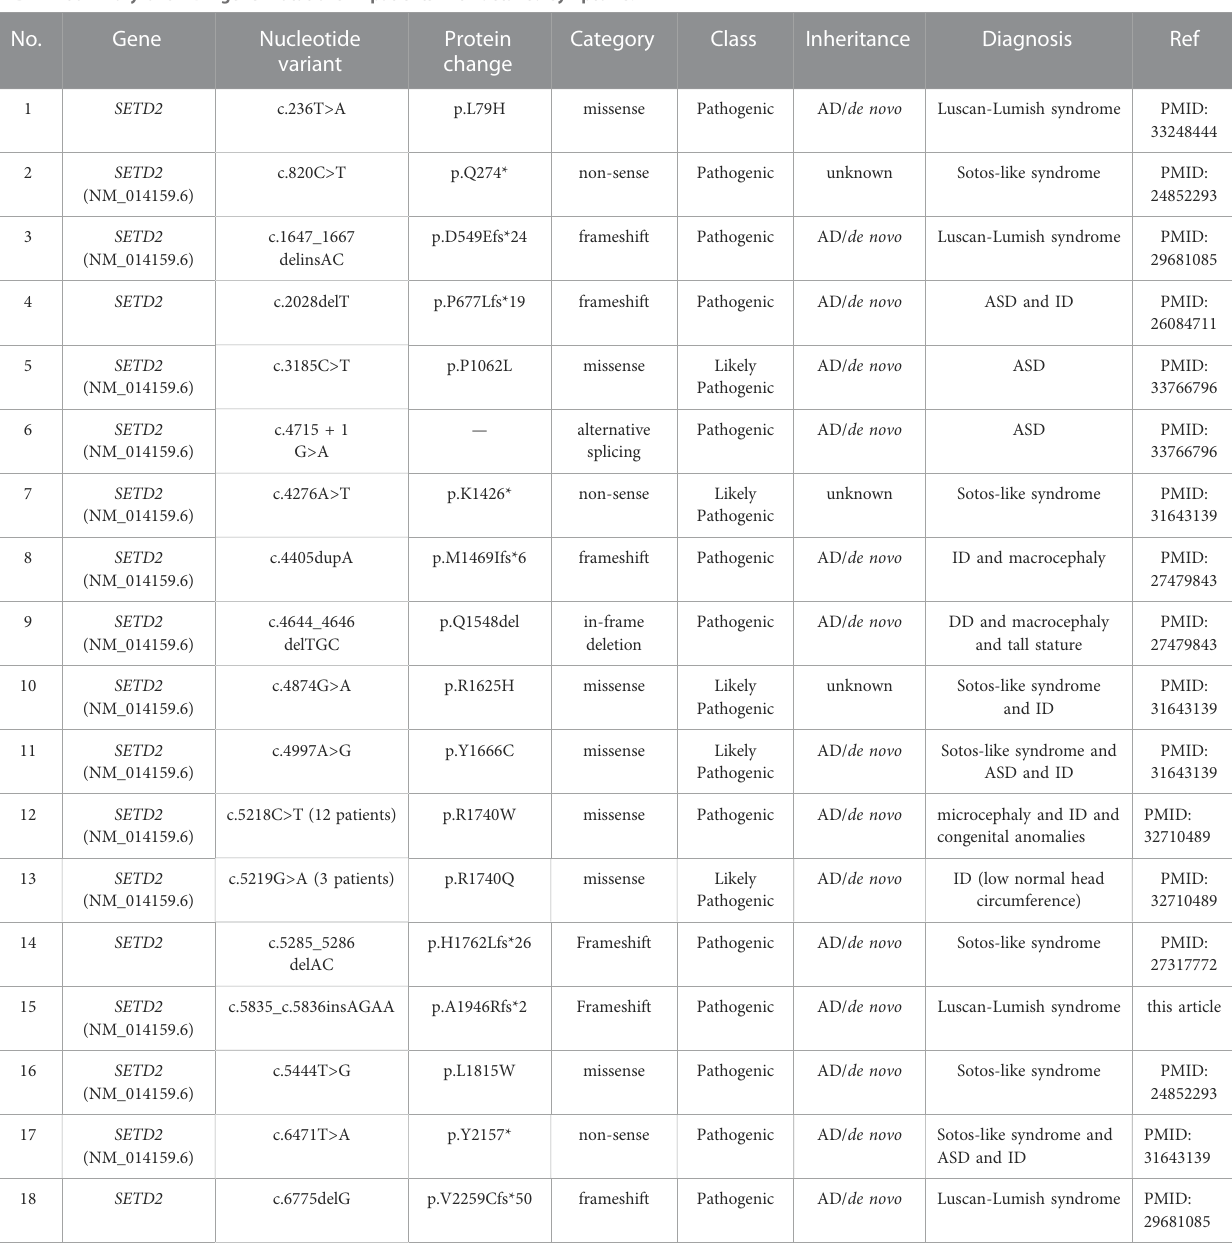
TABLE 1 Summary of SETD2 gene mutations in patients with detailed symptoms.